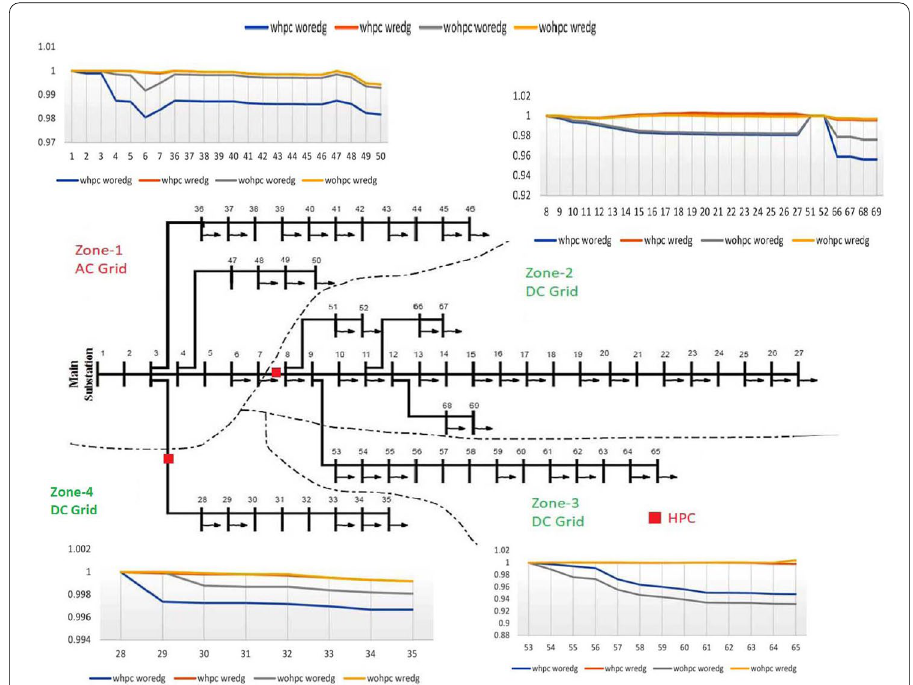
Fig. 7 Zone-wise voltage profile of 69-bus hybrid AC/DC distribution micro-grid for different